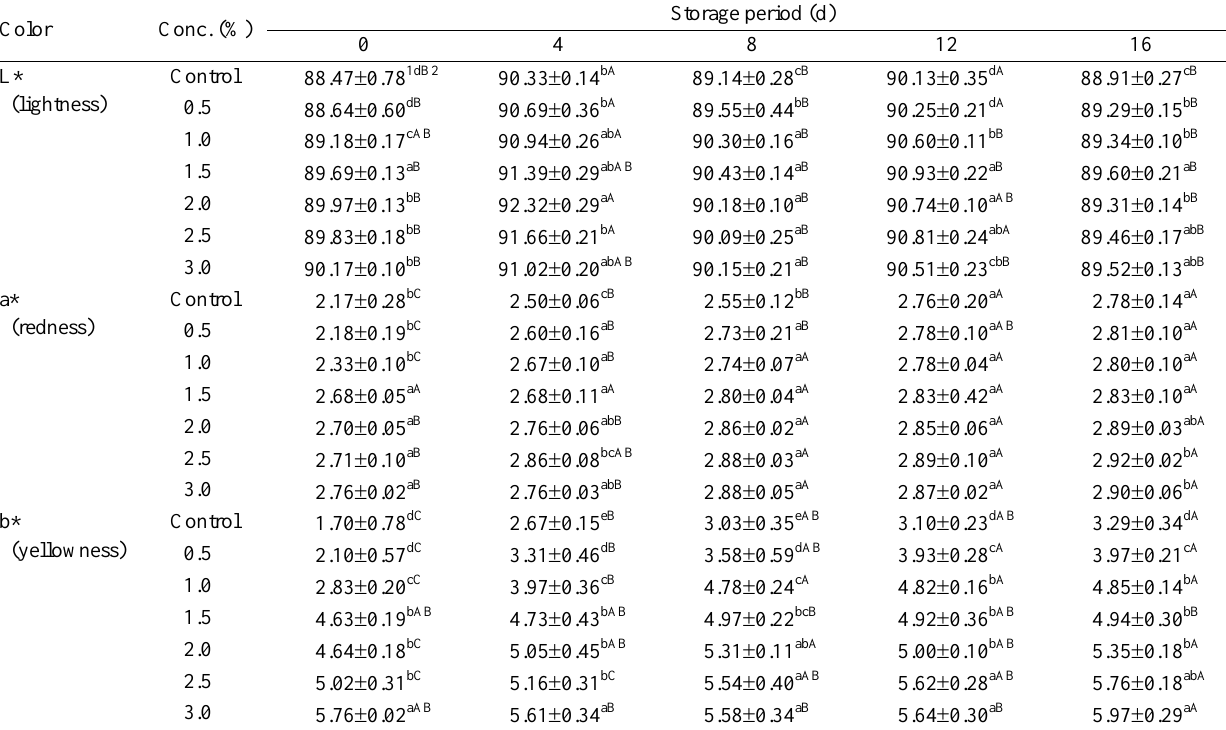
Table 1. Changes in color of powdered peanut sprout extract microcapsule-supplemented milk stored at 4  C for 16 d Color Conc. (%)